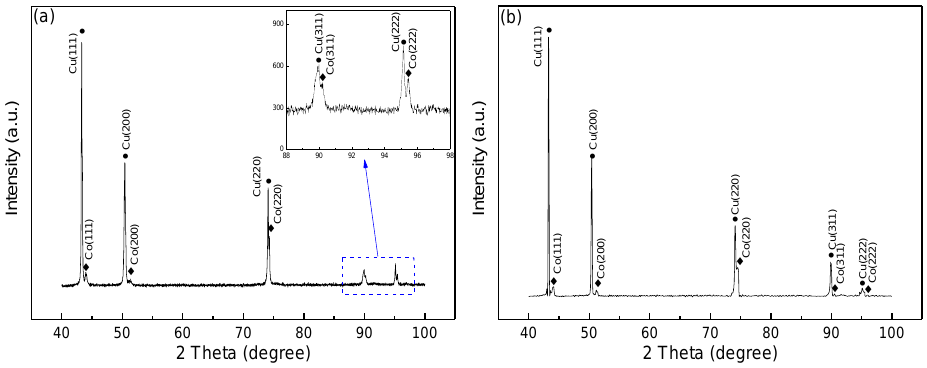
Figure 3. The X-ray diffraction (XRD) pattern of a Cu-15%Co alloy: ( a ) without EMS; ( b ) with EMS of 200 A/ 16 Hz.